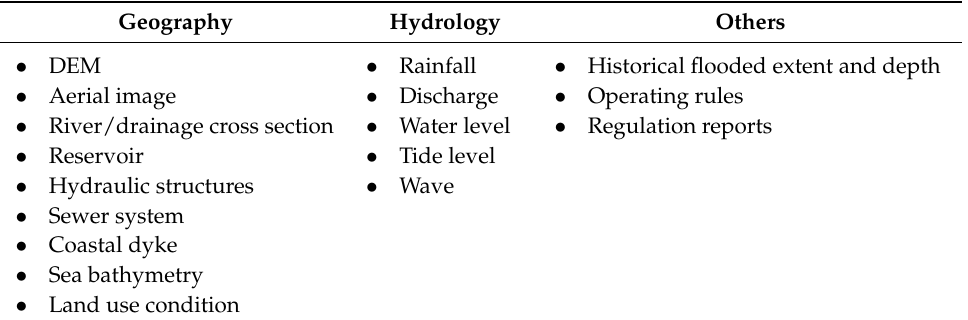
Table 1. List of data required for development of a flood inundation